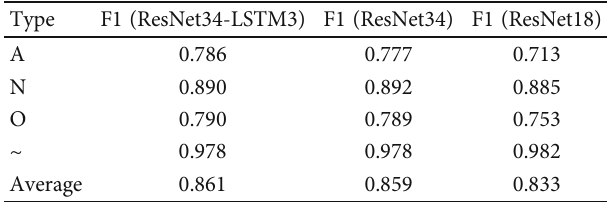
Table 5: F1 scores of three